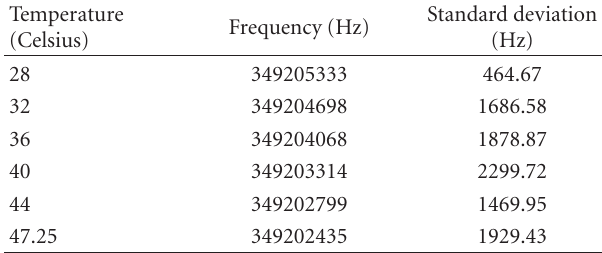
Table 1: CPU clock frequency versus CPU temperature in Celsius. Table 2: Measured clock frequency for light, moderate, and heavy system